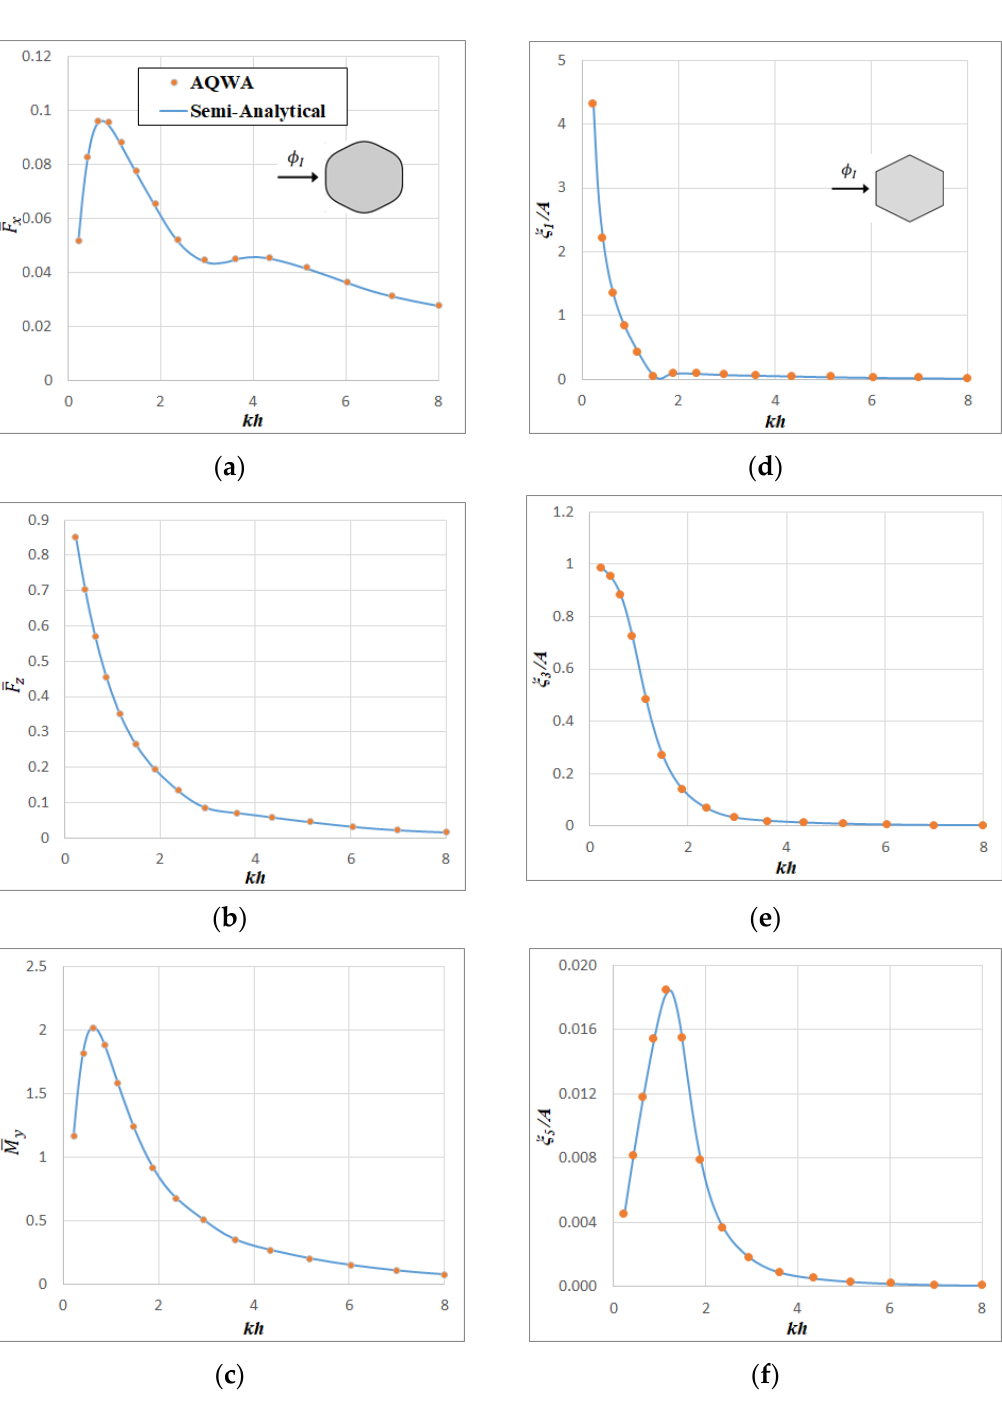
Figure 4. Comparison of wave exciting forces and RAOs obtained from AQWA and semi-analytical approach: ( a ) surge force; ( b ) heave force; ( c ) pitch moment; ( d ) RAO for surge motion; ( e ) RAO for heave motion; and ( f ) RAO for pitch motion.